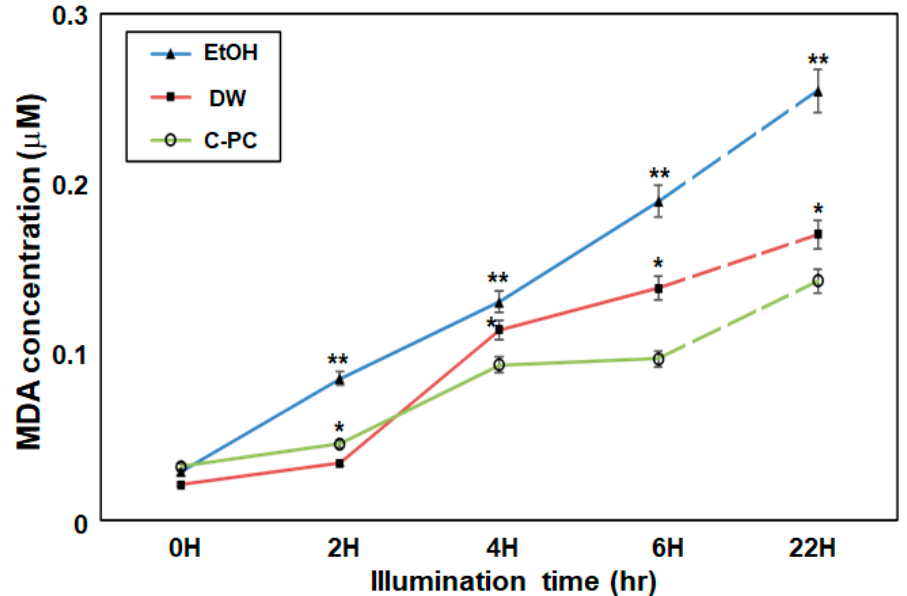
Figure 4. Changes in malondialdehyde (MDA) concentrations of chlorophylls in different media (EtOH, DW, and C-PC) during intense light illumination for 22 h. Linoleic acid was used as a substrate, and the antioxidant effects depending on the amount of chlorophyll a stabilized under intense light illumination conditions. All experiments were performed in triplicates the mean values of which are shown. Error bars indicate standard deviations; asterisks indicate significant differences between media (one-way-ANOVA with Tukey’s multiple comparison test, * p < 0.05, ** p < 0.01).